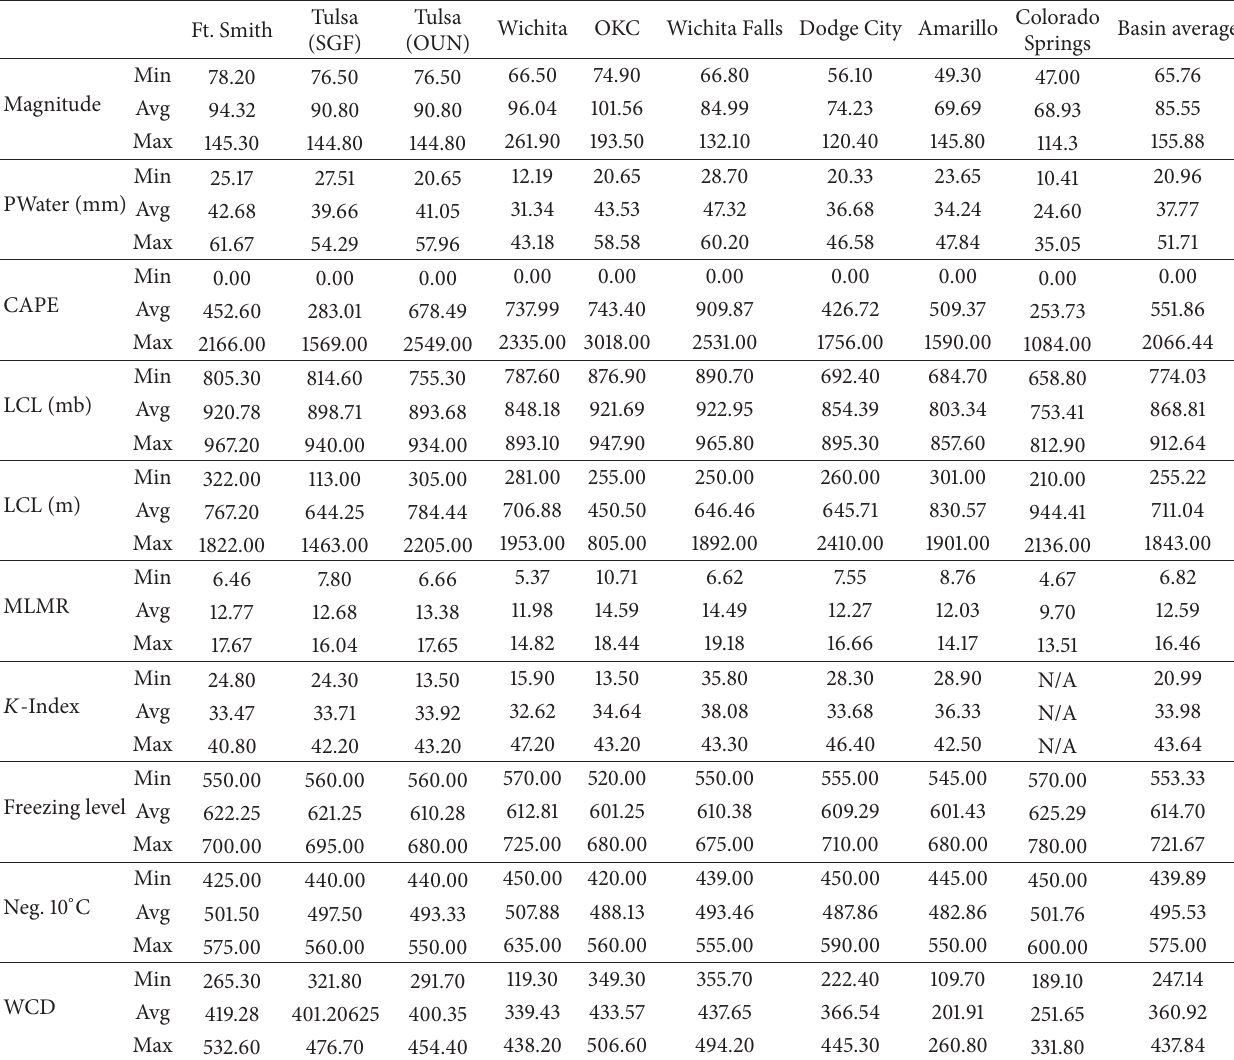
Table 8: Minimum, maximum, and average values of sounding parameters for each location as well as the basin average. Ft. Smith Wichita Falls Dodge City Amarillo